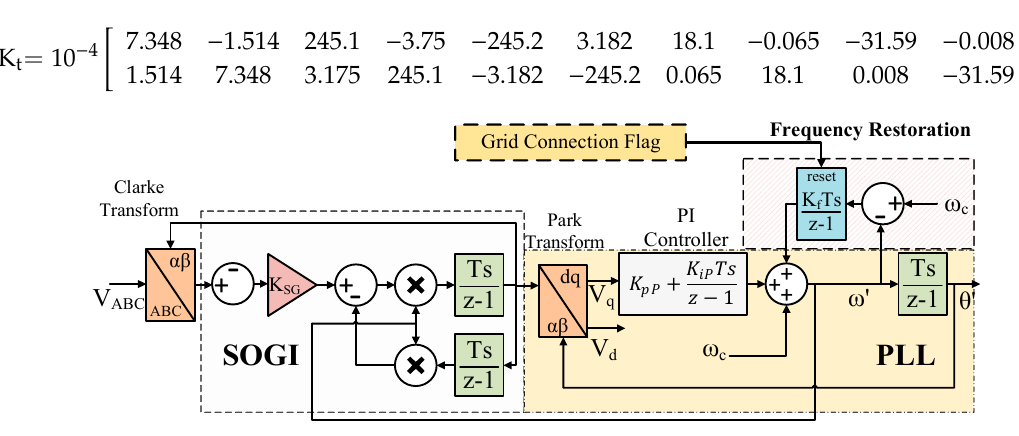
Figure 23. Modified SOGI-PLL.